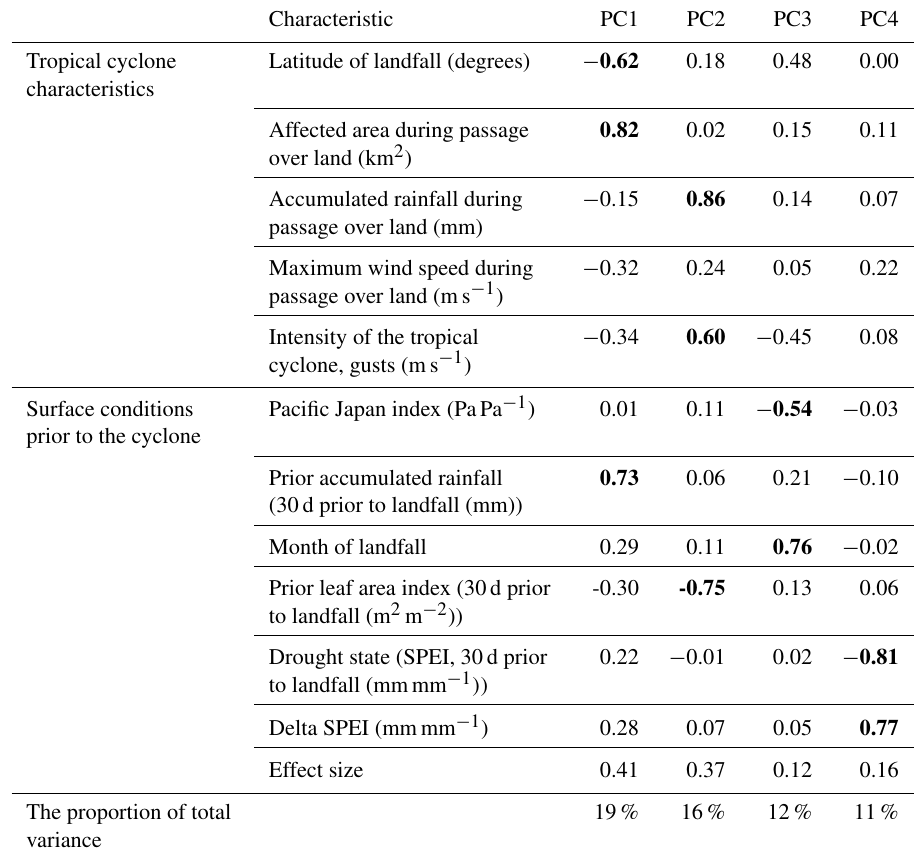
Table A2. Loadings of each characteristic on four principal axes and collinearity between variables within the same group. Given the exploratory nature of this analysis, a factor loading of 0.6 was used as a cutoff, and those values exceeding that level are highlighted in